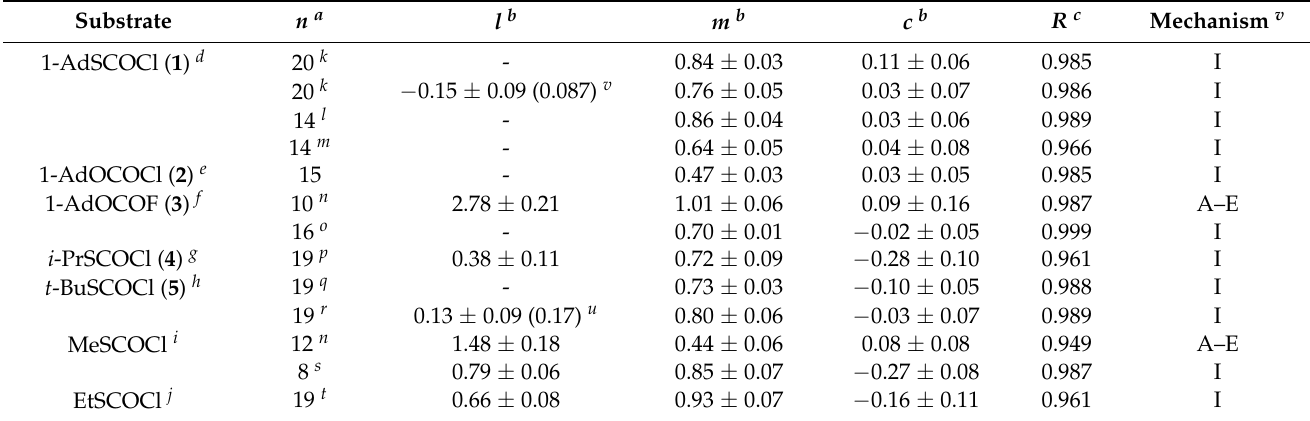
Table 6. Correlations of the rate constants of reaction of chlorothioformate esters and haloformate esters and using the simple and extended Grunwald–Winstein